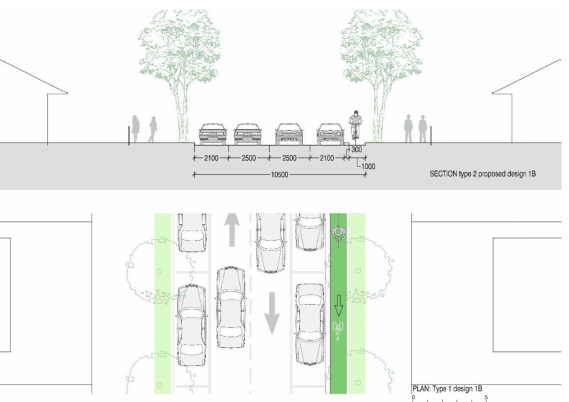
Figure 5. Section and plan drawings showing proposed retrofit ‘Design 1B’ for opposite direction of a reconfigured ‘Type 1’ street including a 1 m single cycling lane and 0.3 m wide physical barrier with similar roadway, but 2.1 m parking lanes on either side of the streets and two-way single traffic lanes of 2.5 m width to accommodate 40 km/h speed limit.